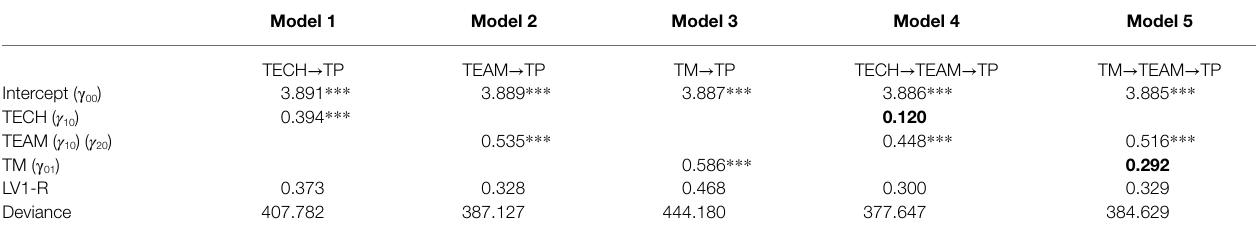
TABLE 3 | Regression model of direct and indirect effects on individual task